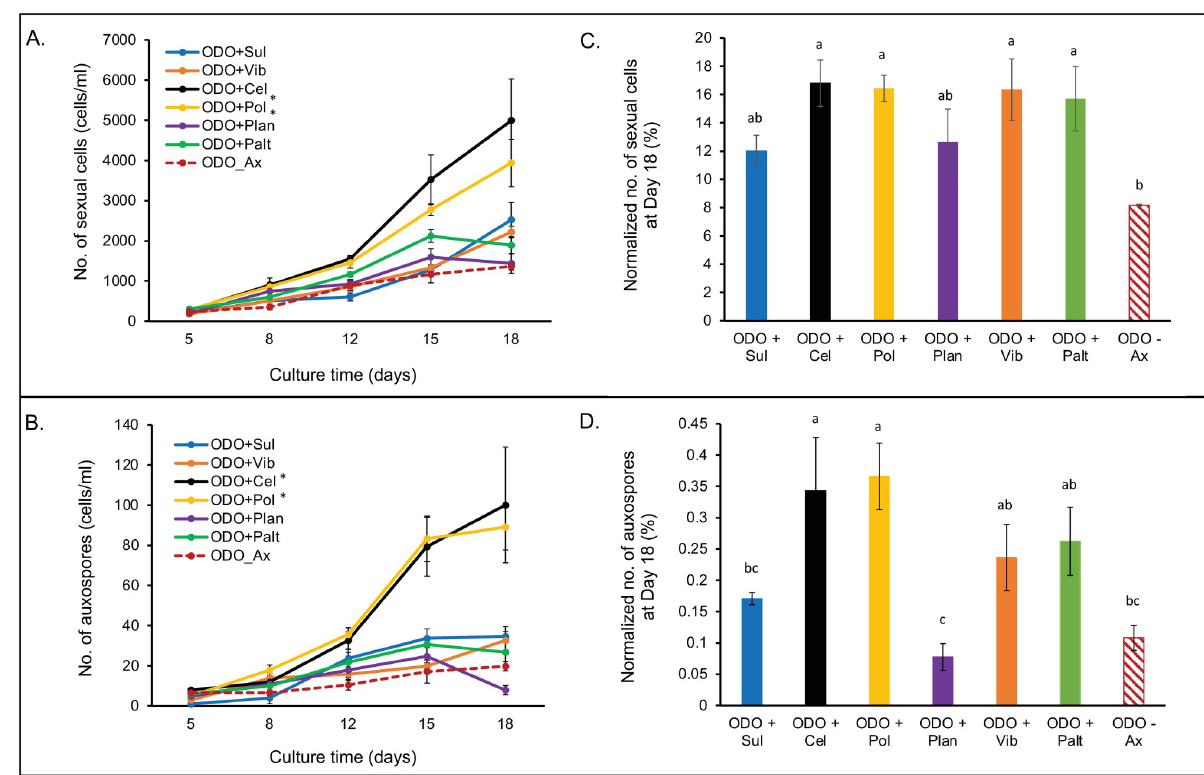
Fig 5. Differences in the number of sexual cells and auxospore production of Odontella sp. co-cultured with various bacterial isolates. ( A) Number of sexual cells. (B) Number of auxospores. (C) Normalized number of sexual cells with total algal density. (D) Normalized number of auxospores with total algal density. Data (n = 4 for each treatment) were log-transformed (A and B) or arcsine-transformed (C and D) and were analyzed using one-way ANOVA followed by pairwise comparisons using Tukey-HSD. � denotes a statistically different number of sexual cells and auxospores than axenic Odontella (Odo_Ax). Column bars with the same letters denote no statistical difference.